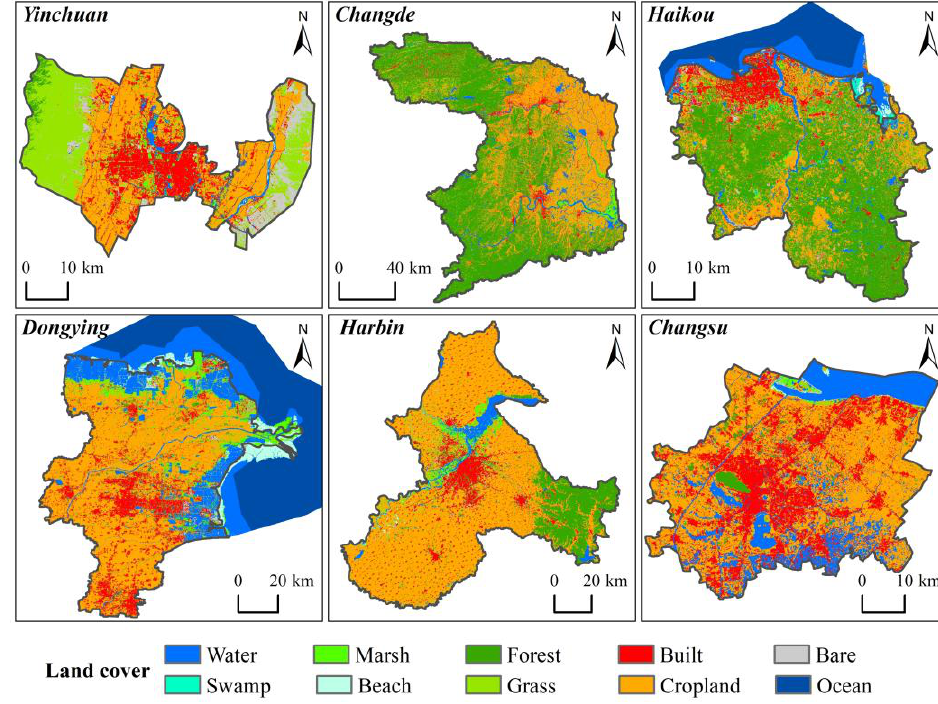
Figure 6. Spatial distribution of land cover for 6 cities in 2015.